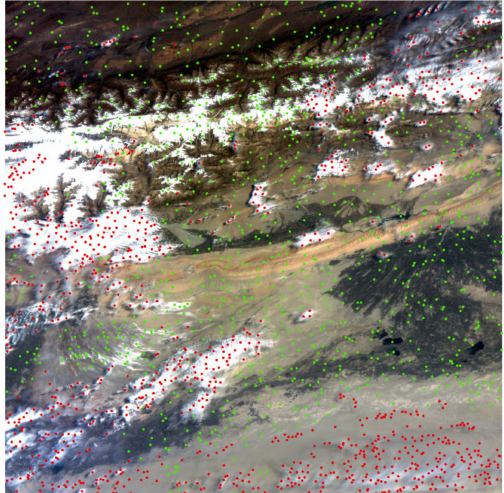
Figure 11. The 2000 points obtained using stratified random sampling from the Xinjiang study area that